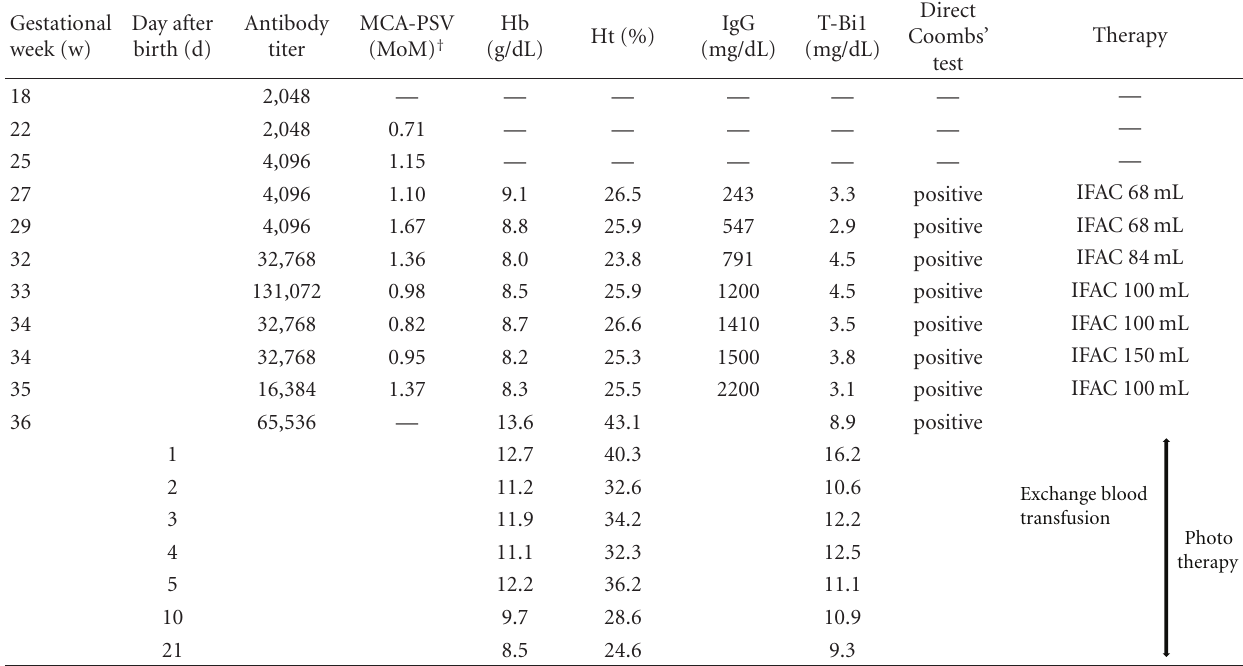
Table 1: The clinical